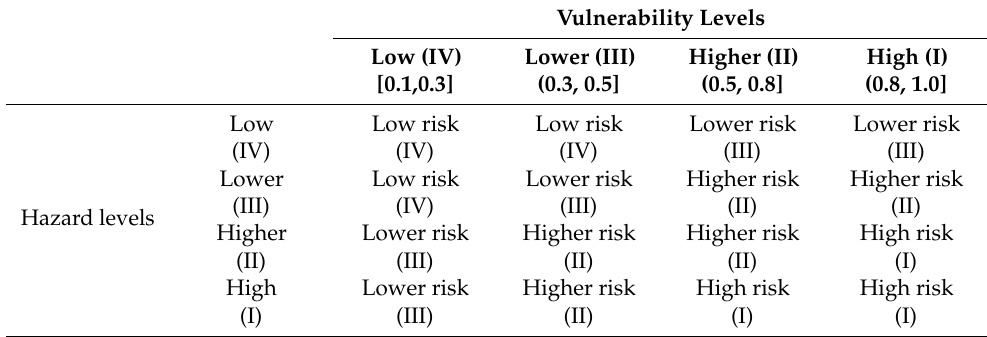
Table 4. Storm surge risk levels in relation to hazard and vulnerability levels